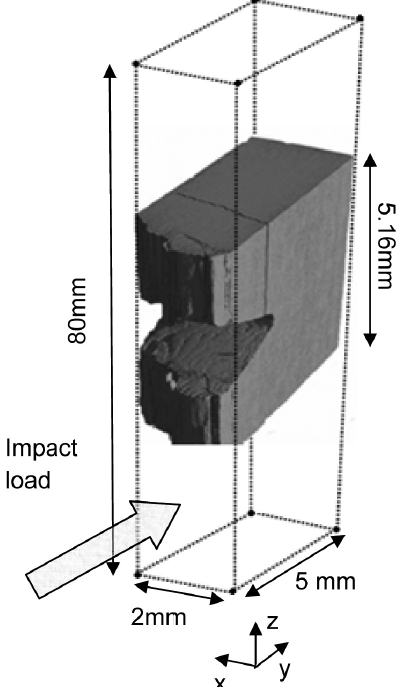
Fig. 7. Inverted view of the region of interest and schematic of the volume of the examined area in comparison with the actual specimen volume. the side and front views of the undamaged specimen are presented. Signs of matrix cracking and fi bre pullout are visible at the edges due to formation of the notch (front view Fig. 5); the cutting plane was perpendicular to the fi bre direction. After 250 impacts the specimen was removed from the IF machine and was re-examined. A